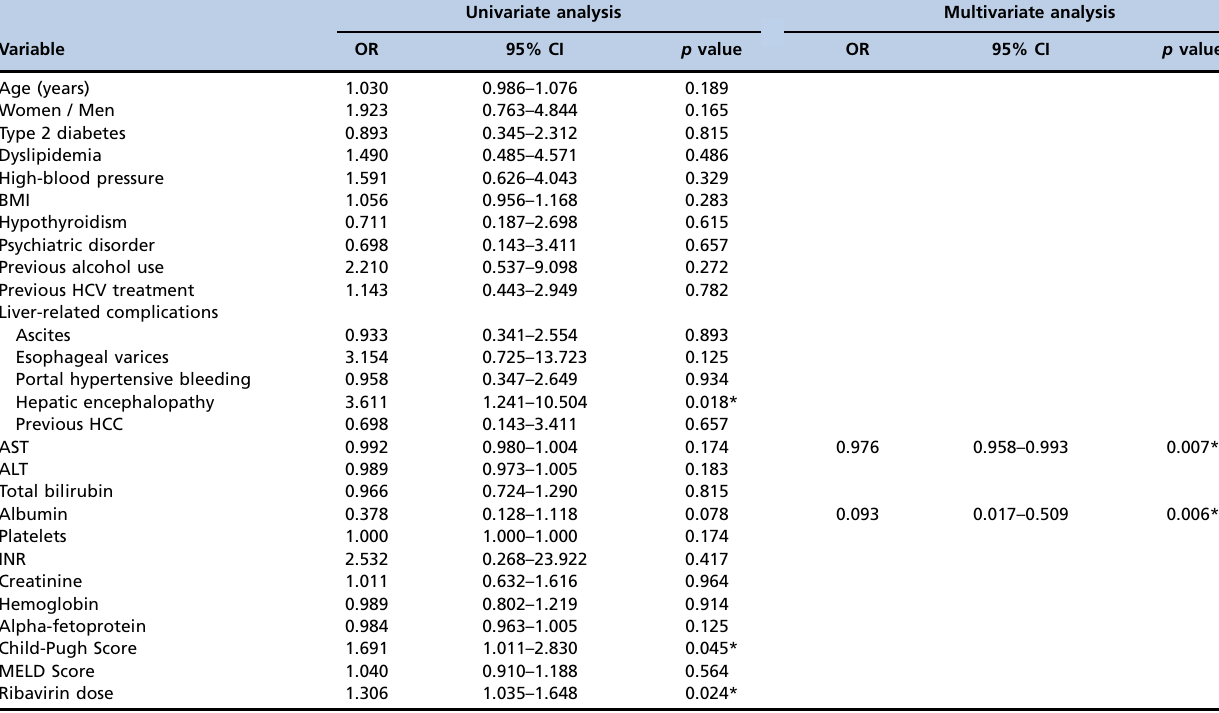
Table 5 - Factors associated with the occurrence of adverse events during treatment (n=76).